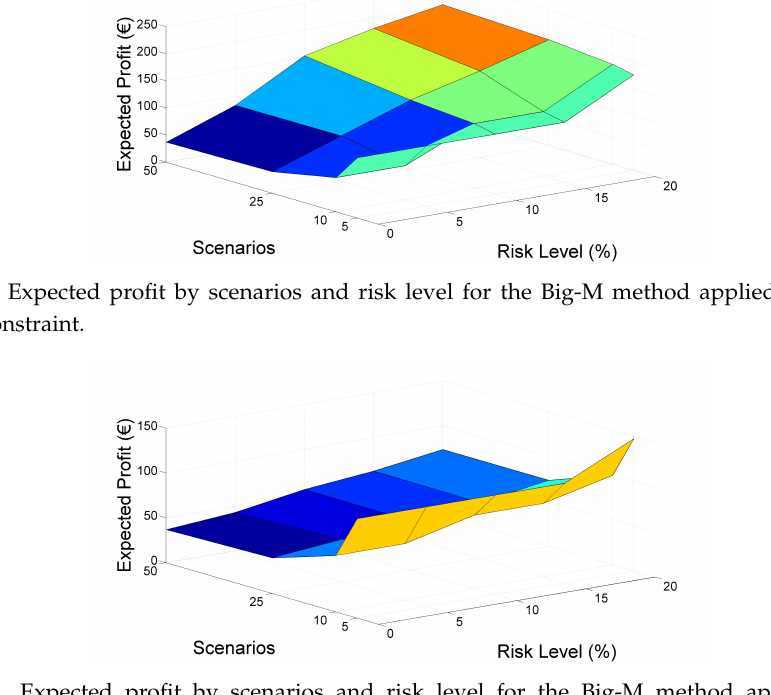
Figure 2. Expected profit by scenarios and risk level for the Big-M method applied to the SOC constraint.